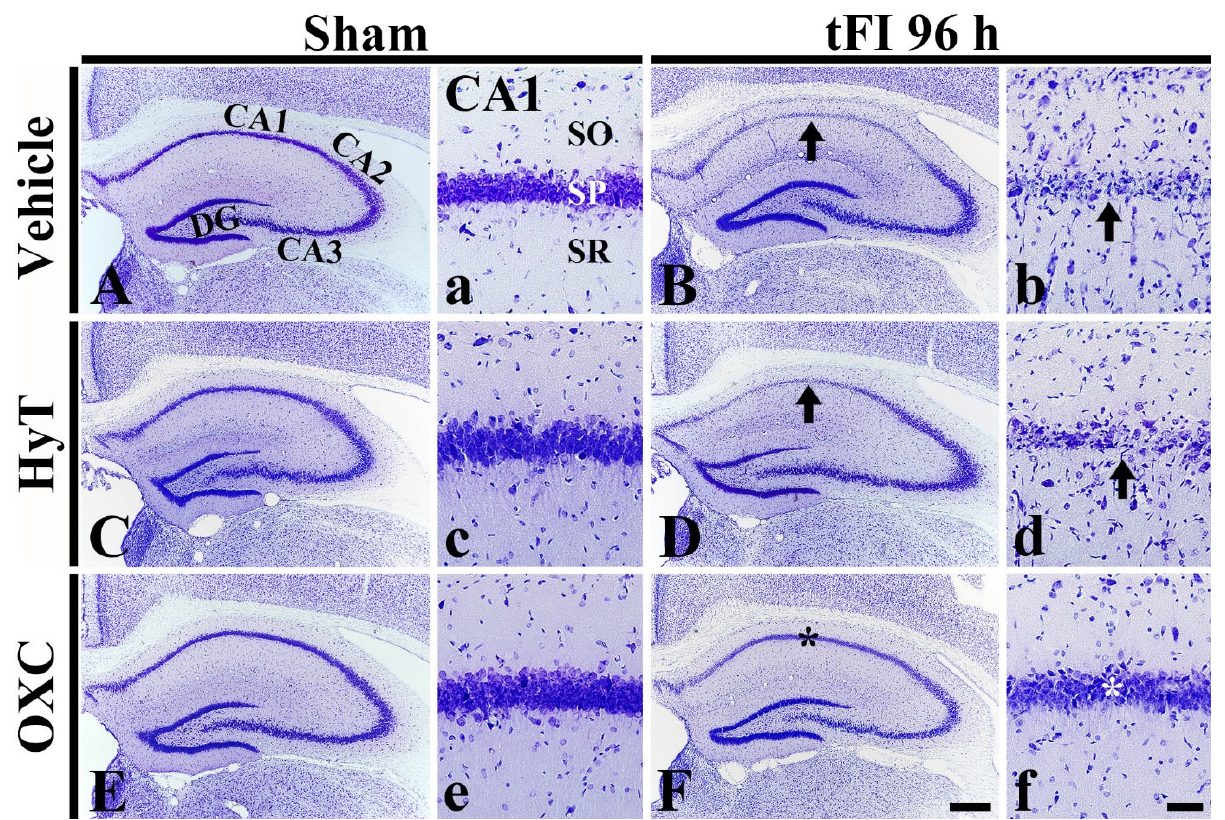
Figure 7. CV staining in the hippocampus and its CA1 region of the sham+vehicle ( A , a ), sham+HyT ( C , c ), sham+OXC ( E , e ), tFI+vehicle ( B , b ), tFI+HyT ( D , d ), and tFI+OXC ( F , f ) groups. In the tFI+vehicle and tFI+HyT groups, CV stainability was apparently reduced in the SP (arrows) of the CA1 re- gion. In the tFI+OXC group, however, the morphology of CV + cells was similar to that in the sham+vehicle group. The bars indicate the means ± SEM ( n = 7 for each group). DG, dentate gyrus. Scale bars = 400 µ m ( A – F ) and 100 µ m ( a – f